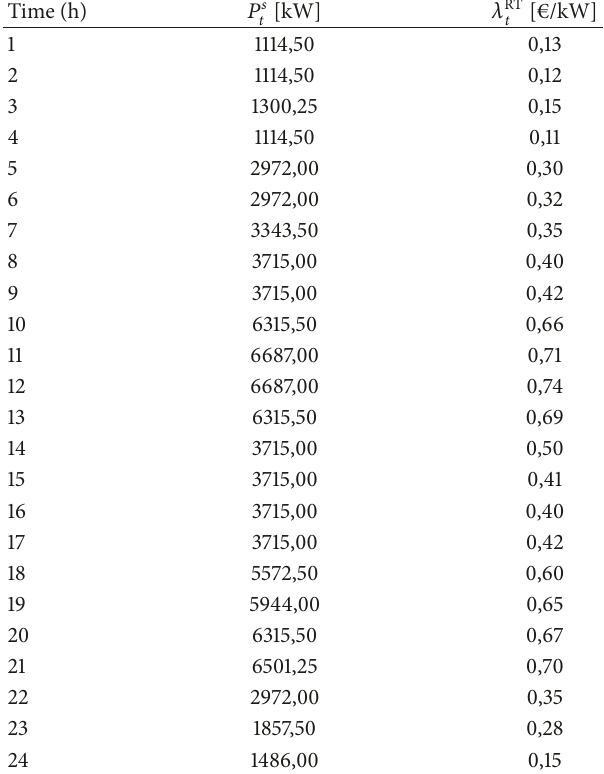
Table 2: Day-ahead market power transactions 𝑃 𝑠 𝑡 and real-time market price 𝜆 RT 𝑡 obtained from